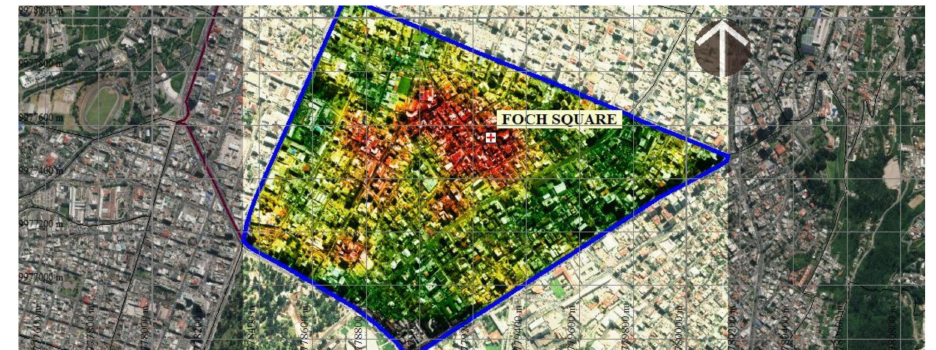
Figure 1. Concentration of economic activities in the La Mariscal neighborhood. The sectors with the largest agglomeration of productive economic activities (red). The sectors with the lowest agglomeration of these activities